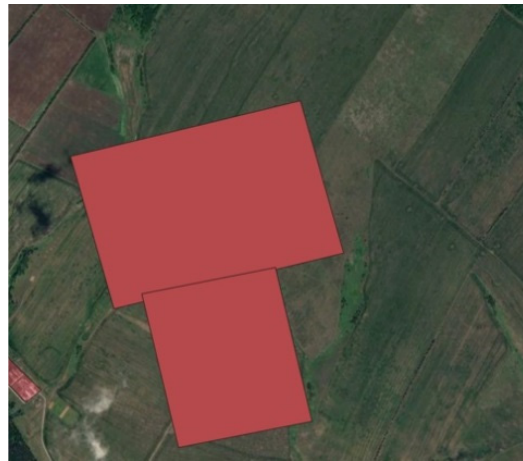
Figure 2. Example of a thermal point.